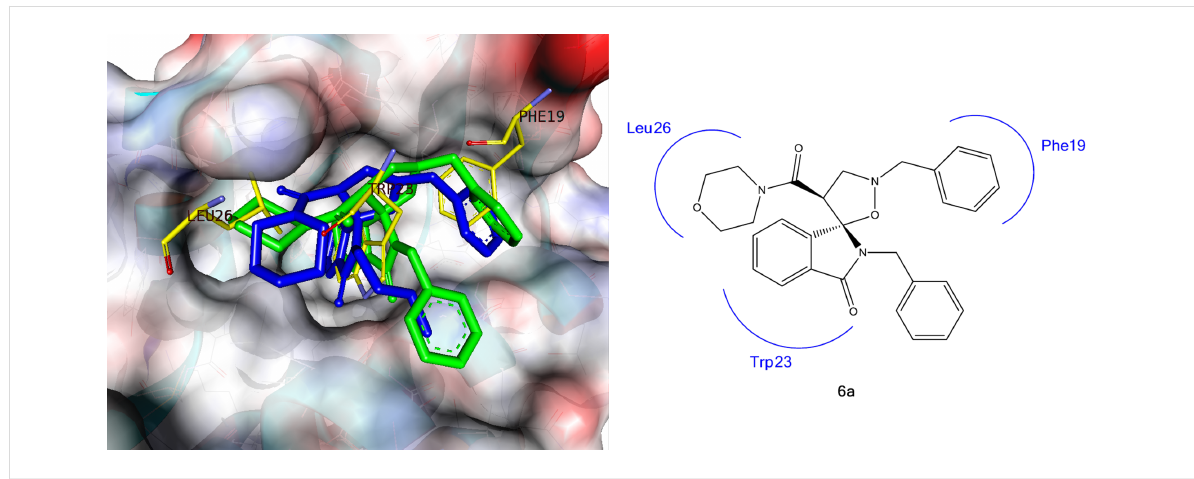
Figure 12: Compounds 6a (green) and 6c (blue) docked into MDM2 structure (PDB-ID: 3LBL) superimposed on the key amino acid side chain residues of the p53/MDM2 (yellow sticks, PDB-ID: 1YCR).